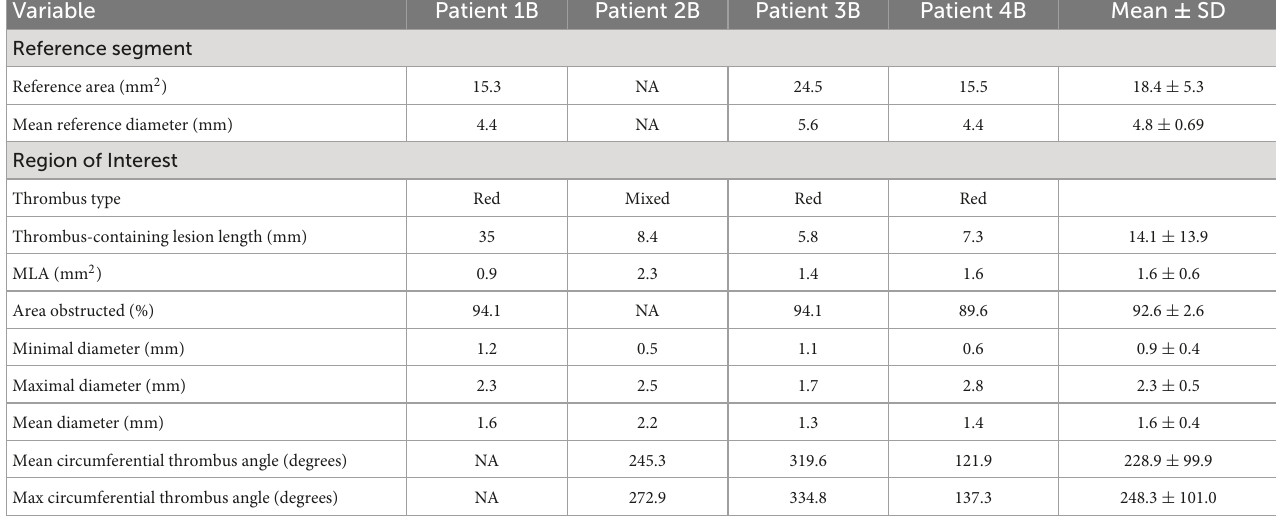
TABLE 2 OCT findings for arteries with thrombus-containing lesions in patients with positive CT scan for pulmonary thrombosis: Cohort B.